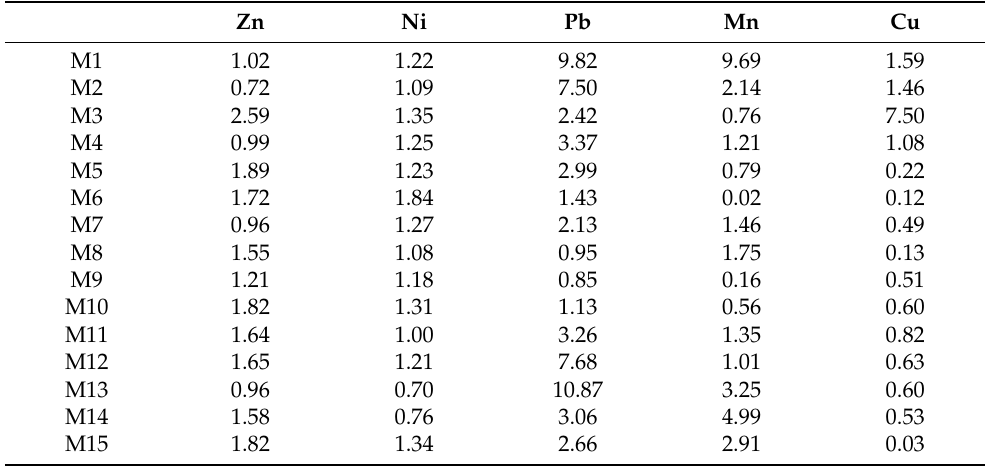
Table 3. Translocation factor from FB to H for selected heavy